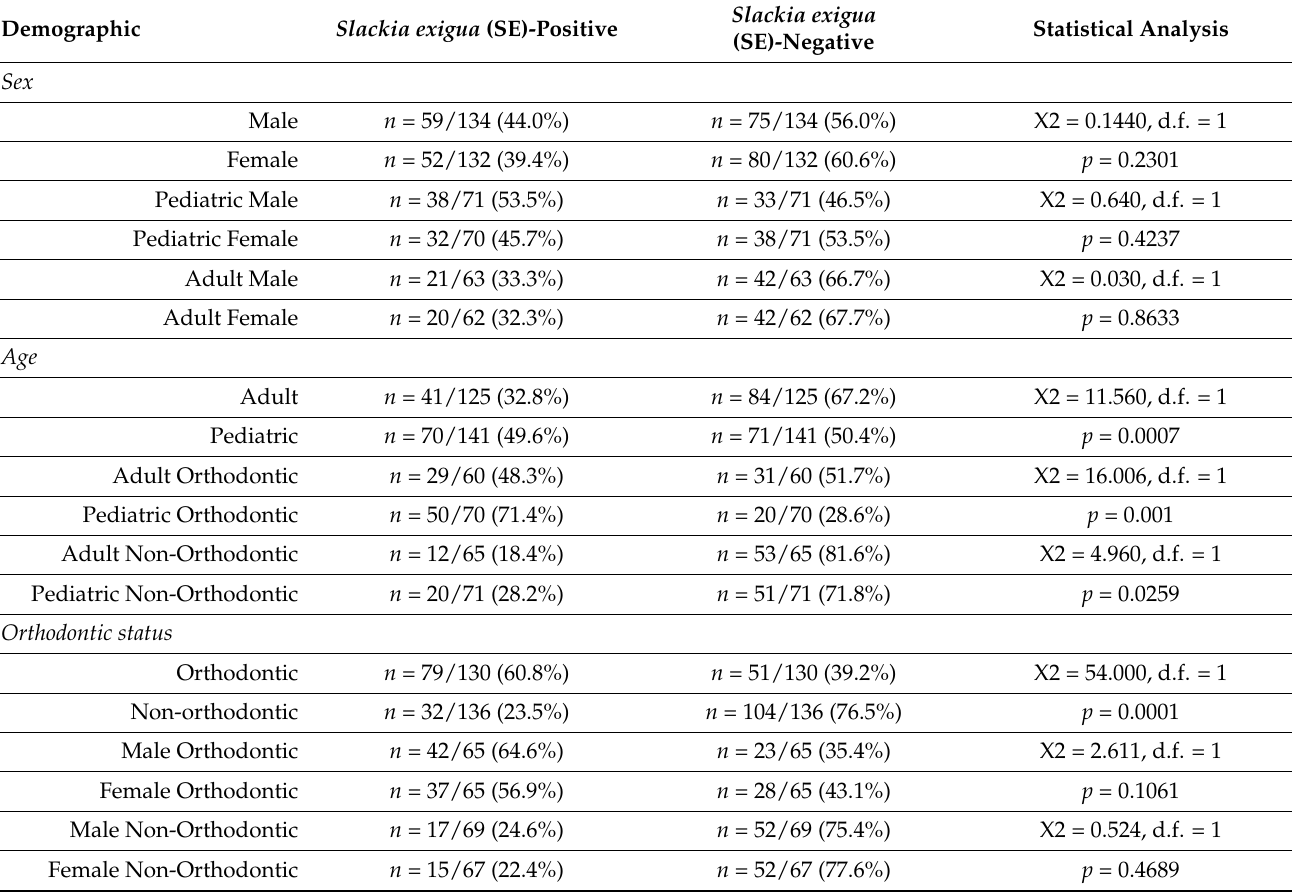
Table 3. Analysis of Slackia exigua (SE)-positive and Slackia exigua (SE)-negative samples by Sex, Age, and Orthodontic